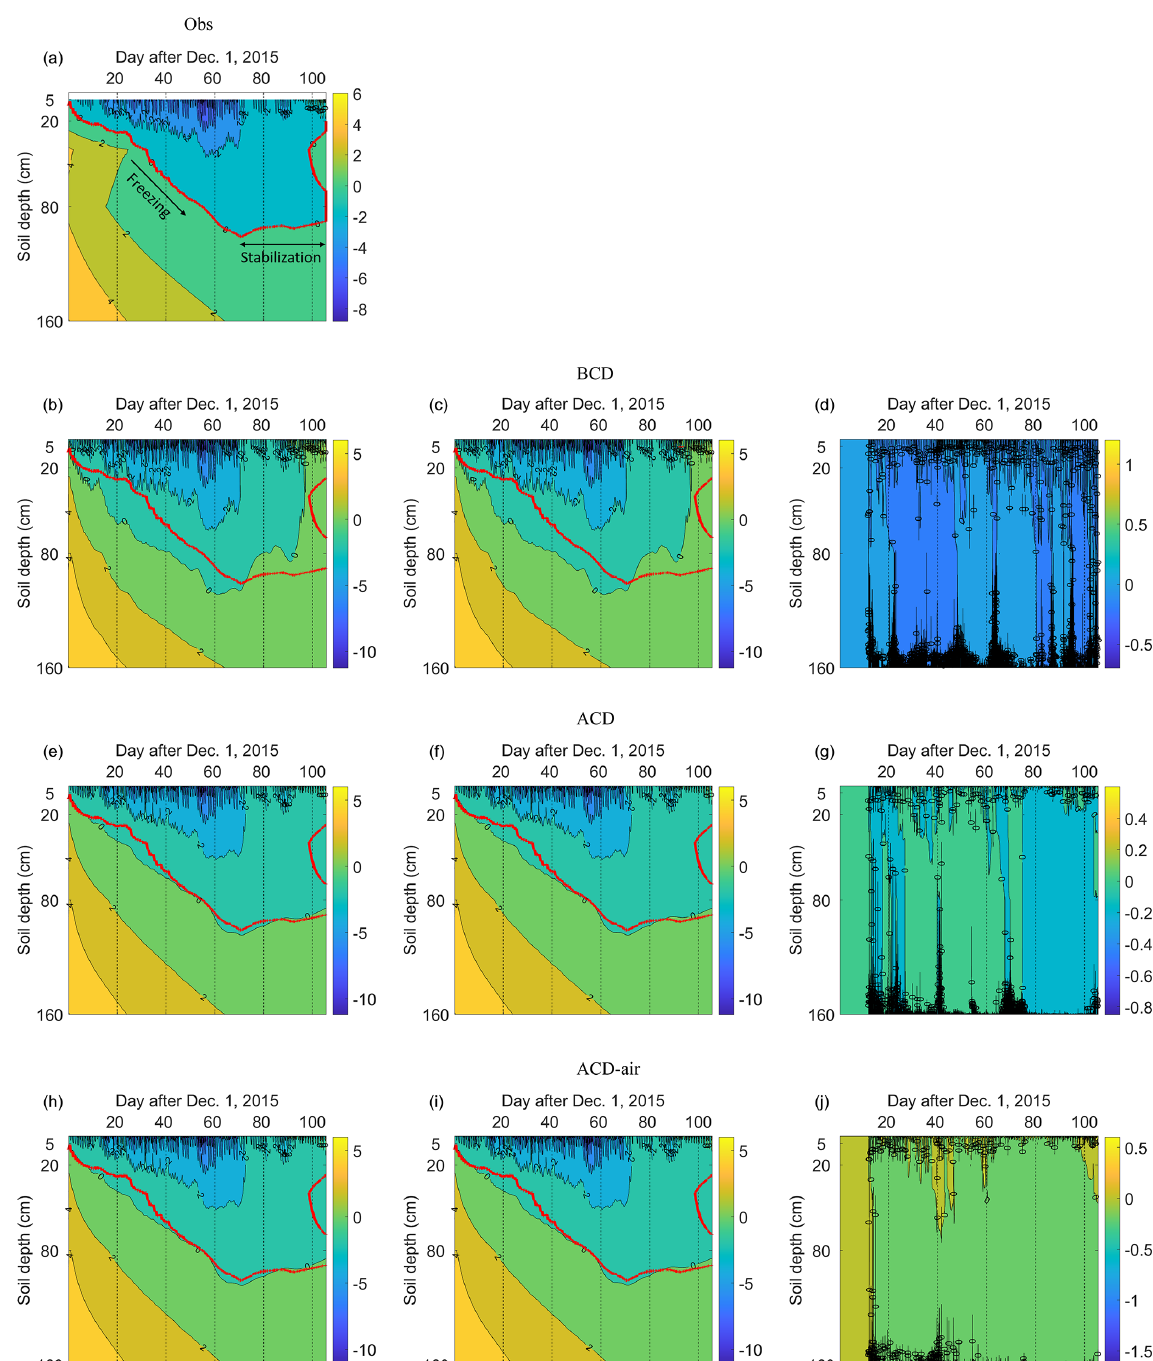
Figure 3. The spatial and temporal dynamics of observed (a) and simulated soil temperature using BCD, ACD, and ACD-air soil models both with and without consideration of the snow module (snow: b, e, h ; no snow: c, f, i ) and the difference between them (d, g, j) (simulations with snow minus simulations without snow). The red line indicates the zero-degree isothermal line (ZDIL) from the measured soil temperature. The observed soil freezing stage and stabilization stage is marked in Fig.